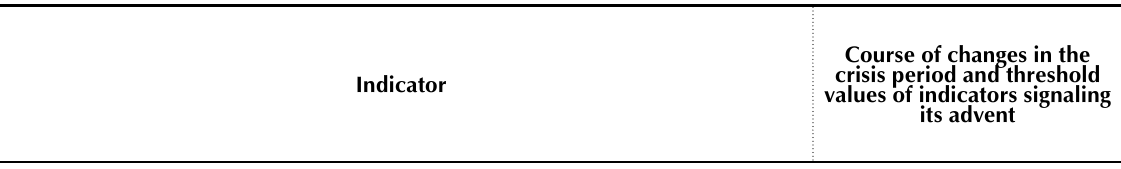
Table 2. Threshold (critical) values of indicators for assessing the banking system stability